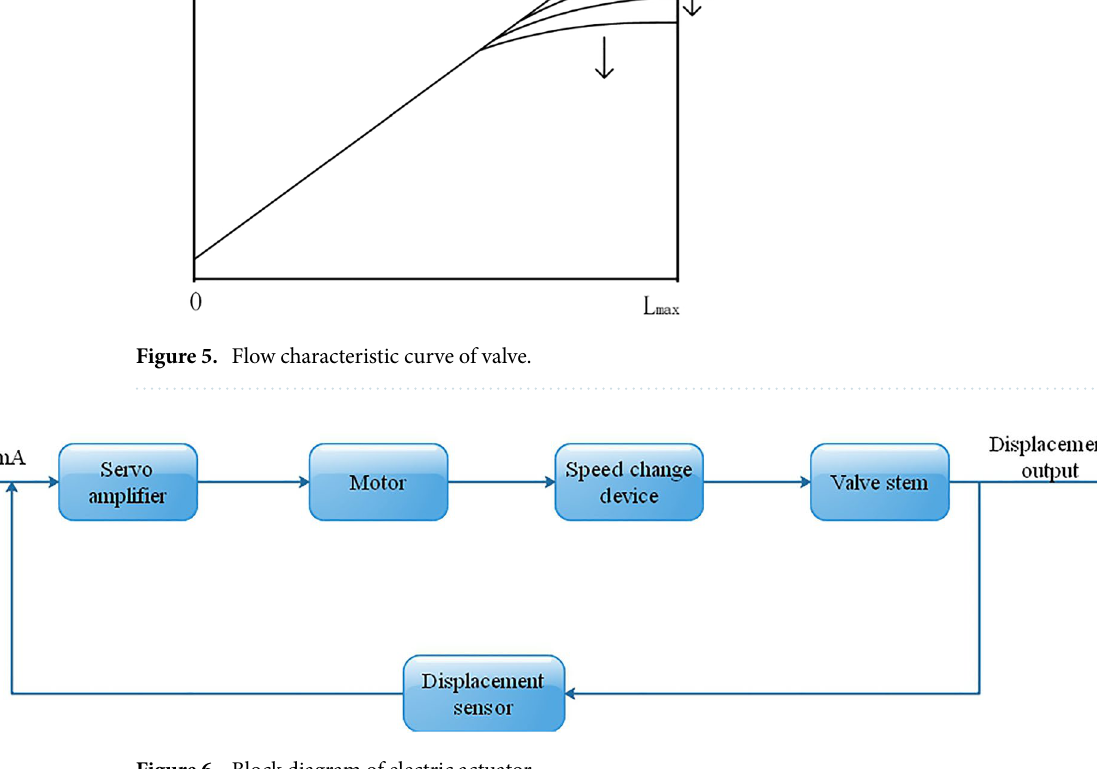
Figure 6. Block diagram of electric